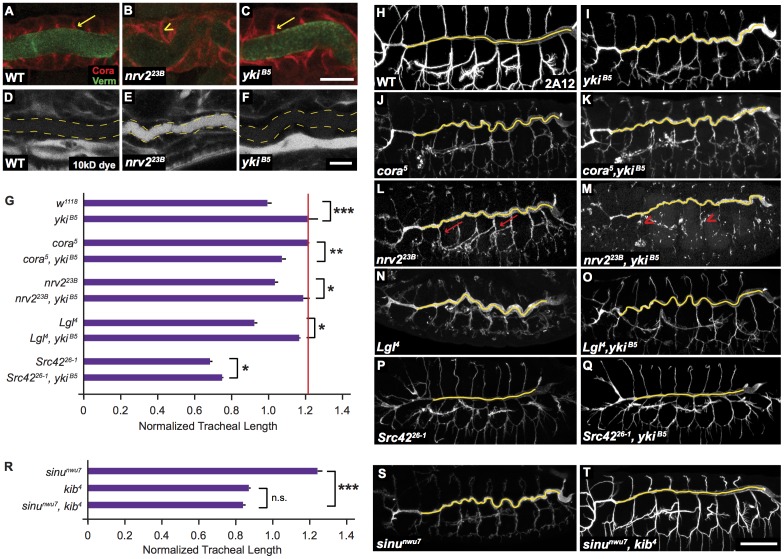
Yki Acts Separately from the Verm/aECM, SJ, Basolateral Polarity, and Src Pathways.(A–F) The localization of lumenal Verm (green) and the SJ marker Cora (red) is similar in the trachea of WT (A) and yki mutant (C) embryos (arrow). In contrast, Verm secretion is dramatically reduced (lack of green staining) and Cora is mislocalized to the lateral membranes (arrowhead) in the SJ mutant nrv223B (B). The SJ paracellular barrier prevents a 10 kD fluorescent dye (white) from leaking into the tracheal lumen (dashed line) in WT and ykiB5 trachea (D,F), but is defective in the SJ mutant nrv223B, in which the dye fills the tracheal lumen (E). Scale bar for (A–F) in (F), 10 µm. (G–Q) Double mutant combinations of ykiB5 with representative mutants in known tracheal pathways all show additive effects of the mutations, suggesting that yki acts in a distinct pathway. (R–T) Double mutant combination of the long SJ mutant sinunwu7 and the shortest Hippo pathway mutant, kib4, reveal that kib4 is epistatic to sinunwu7, suggesting that the Hippo pathway acts downstream or in parallel to the SJ pathway. (H–Q,S–T) Maximum projections of confocal stacks. Yellow lines indicate dorsal trunk measurements. In addition to having increased length compared to either single mutant, the yki, nrv2 double mutant had much more severe lumenal secretion and morphogenesis defects in the lateral tracheal branches than either single mutant (arrows vs. arrowhead in L and M). (G,R) Quantification of tracheal lengths in single and double mutant embryos. The red line in (G) marks the length of ykiB5 mutant trachea for comparison to double mutant combinations. Tracheal length was measured in three dimensions in confocal stacks, normalized to embryo length and then normalized to WT (w1118). Error bars are normalized s.e.m.; *: p<0.05; **: p<0.005; ***: p<0.0005. p-values determined using Student's t-test. Scale bar for (G–P) in (P), 50 µm.